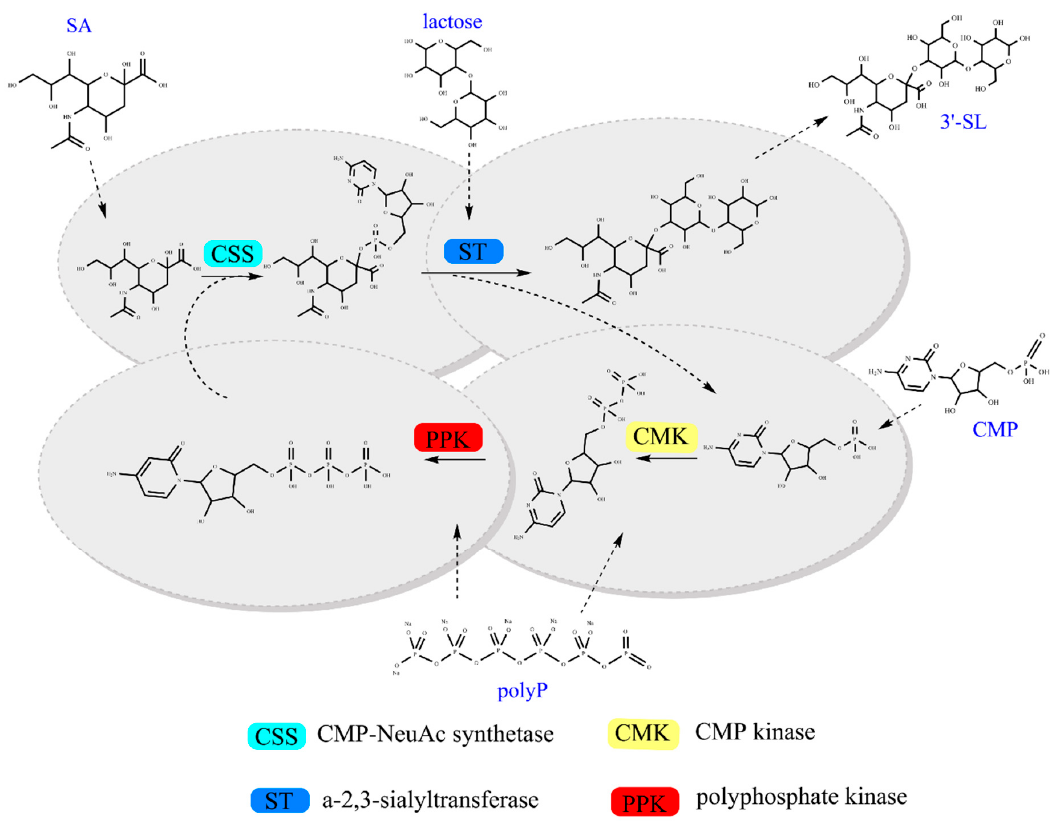
Figure 1. Overview of the multi-enzyme cofactor recycling pathway for 3 ′ -SL production .